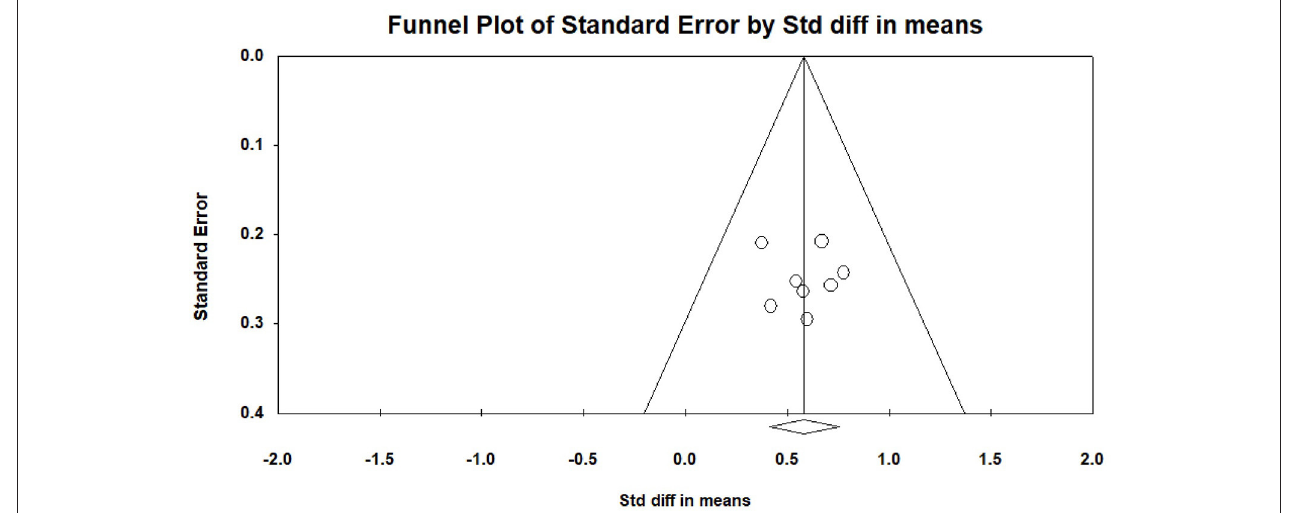
FIGURE 4 | A funnel plot to assess potential publication bias in the secondary analysis.